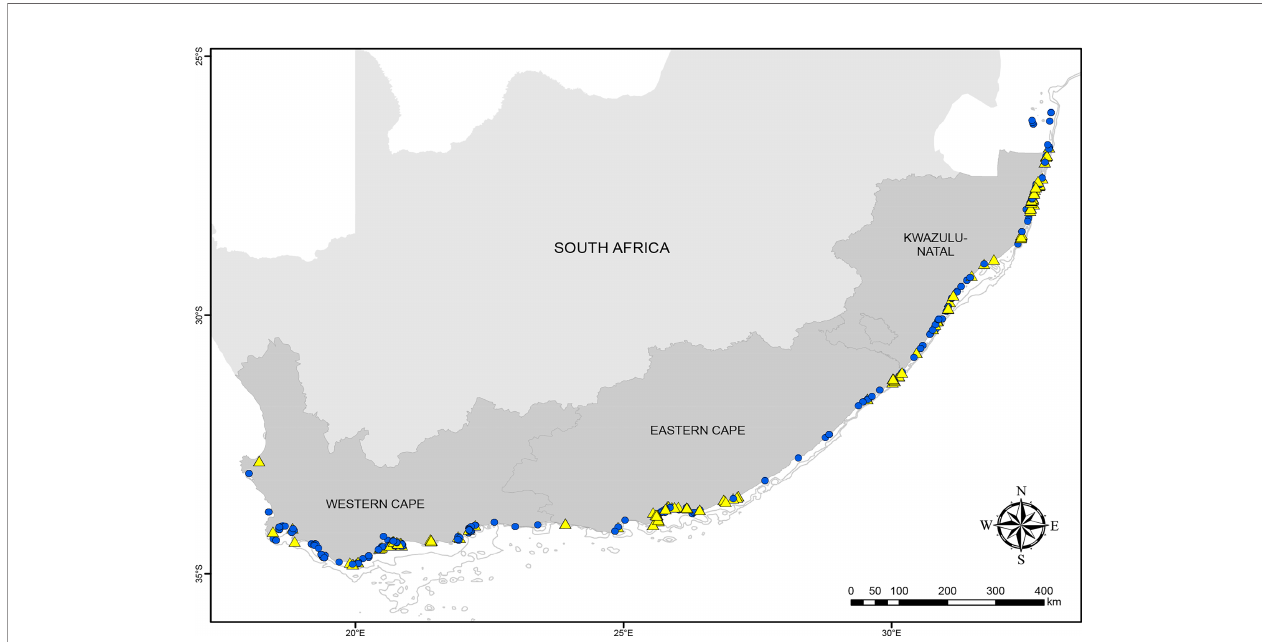
FIGURE 4 | The distribution of tagging effort for both chondrichthyans (blue circles) and teleosts (yellow triangles) has been nationwide along the entire South African coastline.